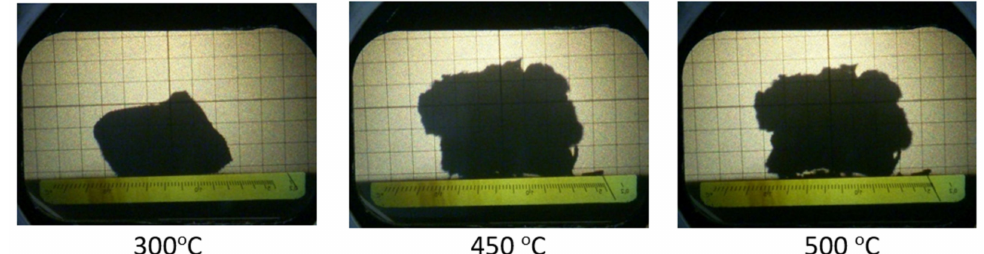
Figure 4. Sample changes in the volume of a coal grain during its carbonization (coal: Budryk; initial diameter of examined coal grain ca. 3